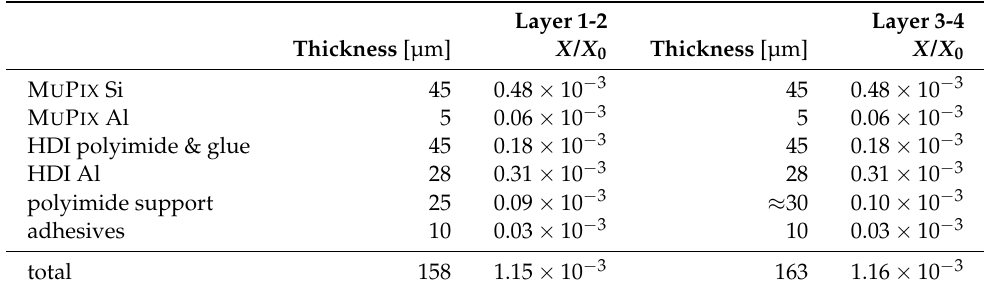
Figure 6. ( a ) Picture of a HDI flex for the tracker inner layers. ( b ) Microscope picture of a HDI aluminum trace spTA-bonded to a test pad. Courtesy of LTU [1]. Table 2. Material budget of a M U P IX ladder. The thicknesses and radiation length are given as an average over the mm width of the ladder. From